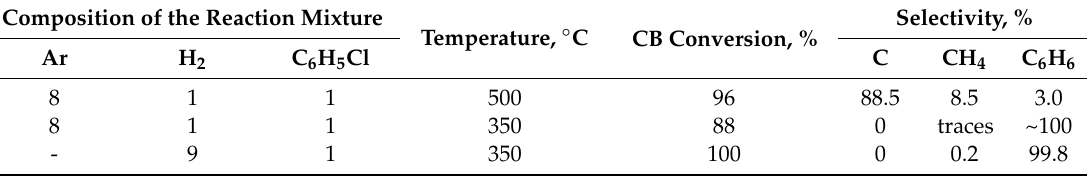
Table 2. Catalytic properties of the Ni / Al 2 O 3 catalyst in the hydrodechlorination of chlorobenzene (CB) at di ff erent temperatures and hydrogen